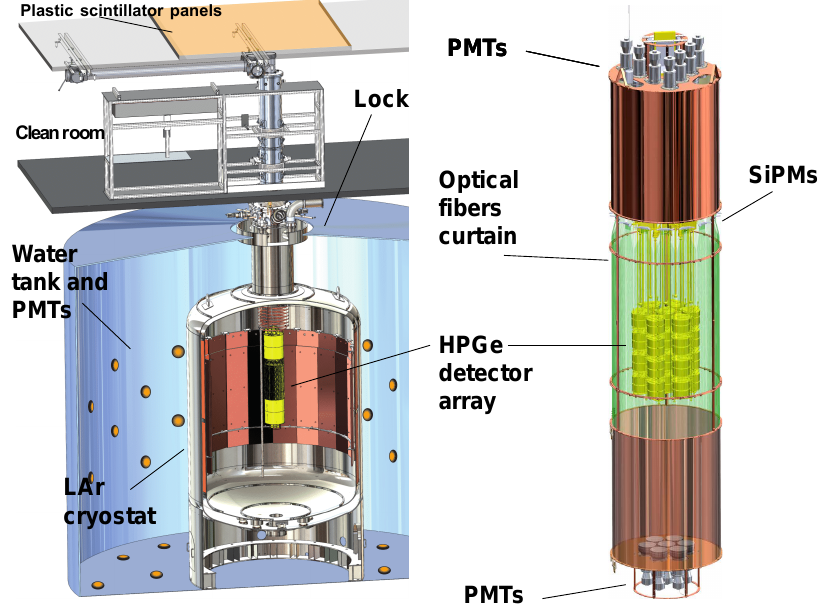
Figure 6. Schematic view of the G ERDA setup. Figure published by Nature, 2017 [62]. The water tank contains a 64 m 3 vacuum-insulated stainless steel cryostat (diameter = 4 m), filled with LAr. The internal walls of the cryostat are covered with a 6 cm low-background copper (Cu) layer to shield the γ radioactivity originating from the